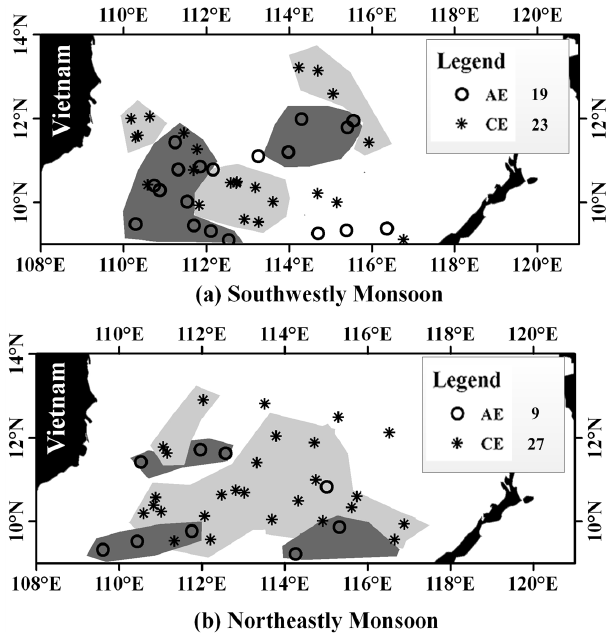
Fig. 9. Eddies of A8, A9, A10, C5 and C6 generated in southern SCS during different monsoon seasons. Concentration regions of AEs and CEs are represented by different